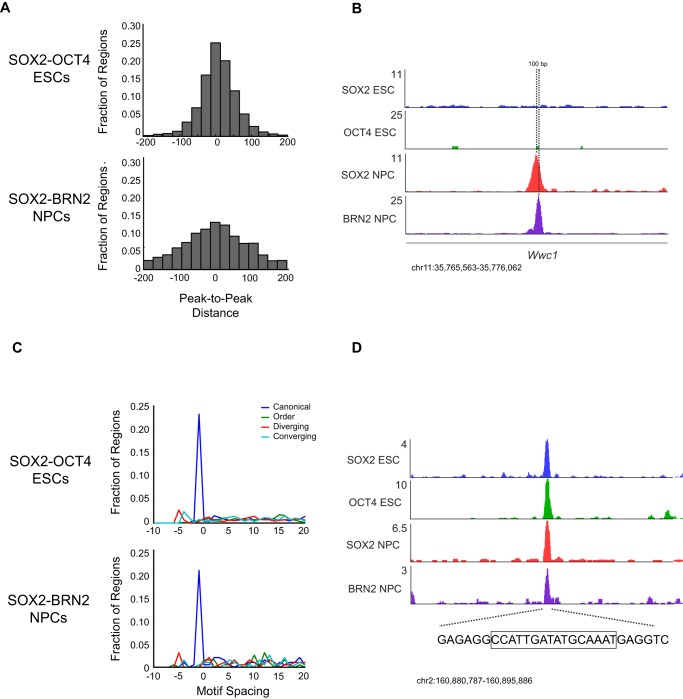
Motif configuration affects binding by SOX2 and cell-type-specific POUs.(A) Frequency distribution of distances in 25 base pair bins between peaks of OCT4 (top) and BRN2 (bottom) from SOX2 bound peaks. (B) Gene plots at the Wwc1 locus. Direction of transcription (5′-3′) is left to right. Hashed line represents position of peaks of SOX2 and BRN2 enrichment separated by 100 bp. y-axis corresponds to reads per million. Genomic positions reflect NCBI Mouse Genome Build 36 (mm8). (C) Distribution of orientation of and distance in base pairs between of SOX and POU motifs within SOX2-OCT4 (top), SOX2-BRN2 (bottom) bound regions. Negative values on x-axis reflect instances where SOX and OCT TRANSFAC motifs overlap. y-axis reflects fraction of occurrences of indicated spacing and orientation of all bound regions which contain a SOX and OCT motif. (D) Gene plots 3′ of the Chd6 locus, which contains a SOX-OCT motif in the canonical orientation with a −1 bp spacer. Hashed line represents sequence under the peaks of enrichment, and boxed sequence represents the canonical SOX-OCT motif with a −1 bp spacer at this locus. y-axis corresponds to reads per million. Genomic positions reflect NCBI Mouse Genome Build 36 (mm8).